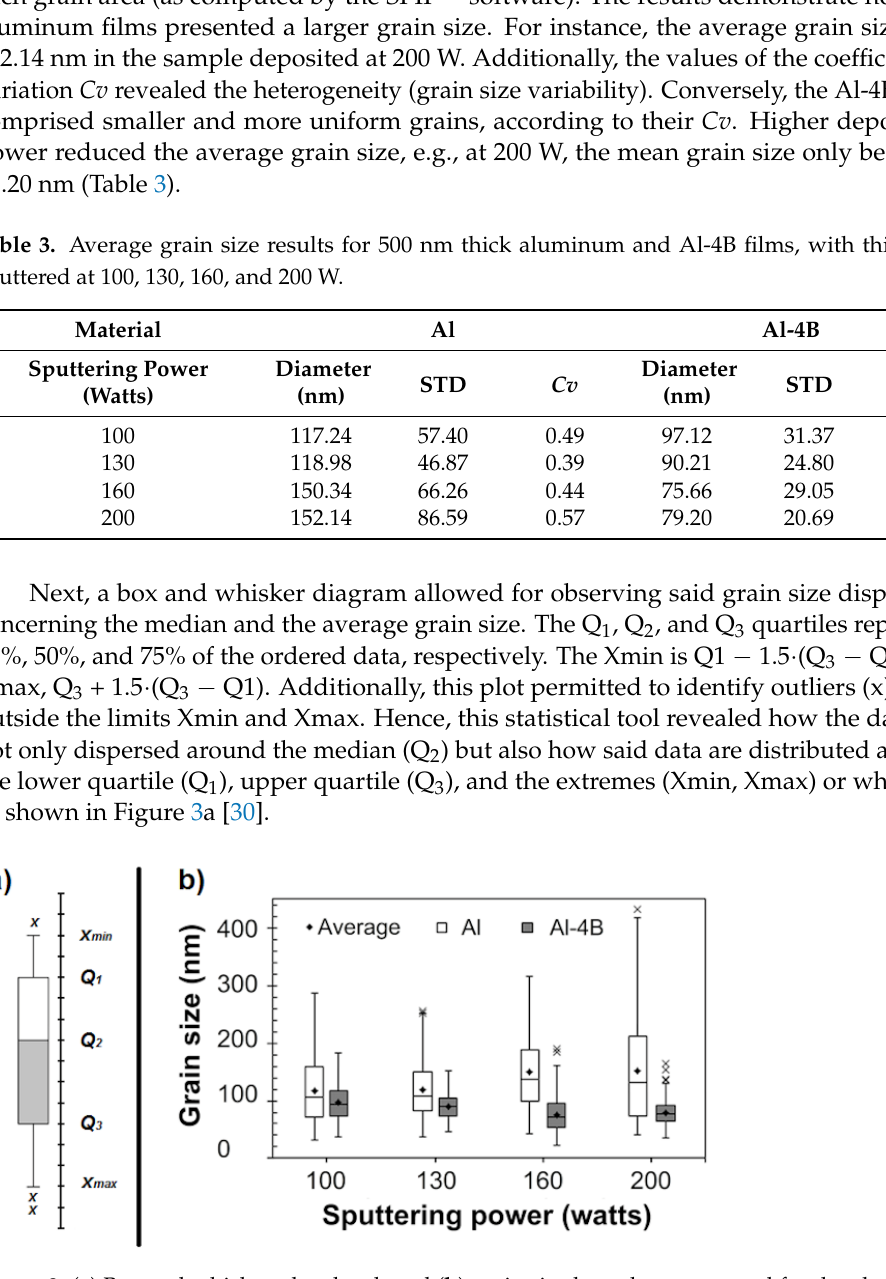
Figure 3. ( a ) Box and whisker plot sketch and ( b ) grain size box plots computed for the aluminum and Al-4B films as a function of the sputtering power. and Al-4B films as a function of the sputtering